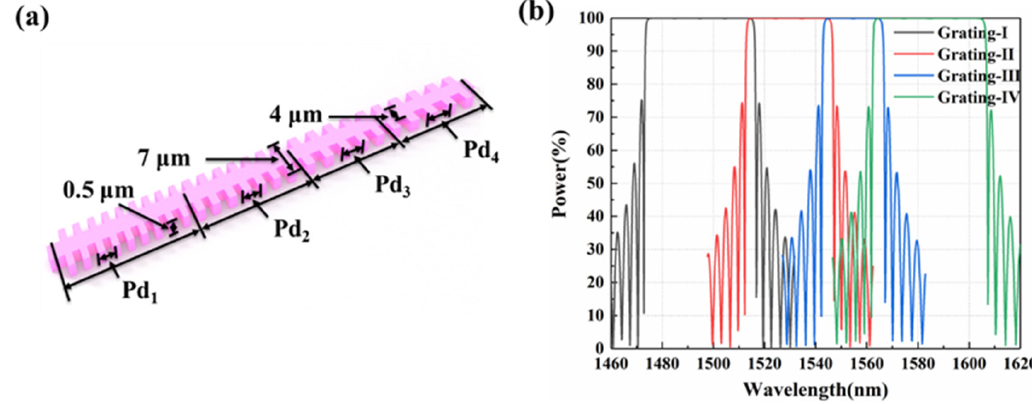
Figure 4. Reflection gratings: ( a ) unit structure; ( b ) reflection spectra. Table 2. Detailed parameters for reflection grating s .